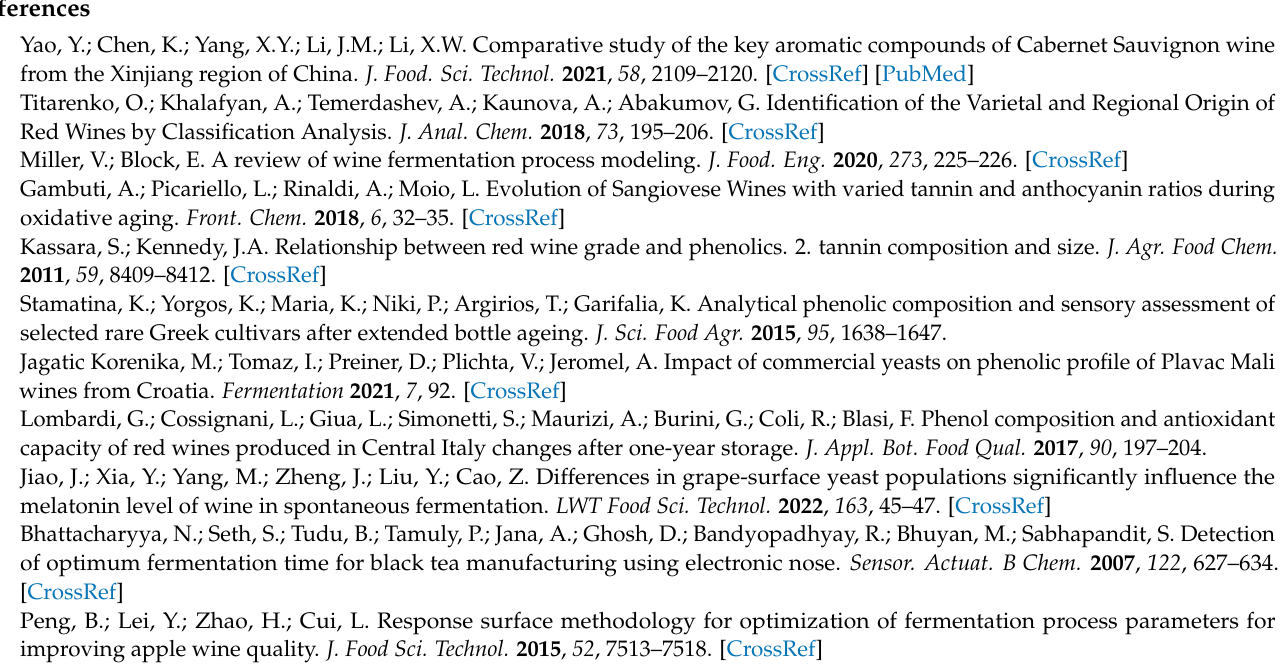
(b); Figure S2: the clustering analysis of twelve phenolic compounds in seven grape cultivars (a) and corresponding wines (b); Figure S3: overlay of the main ion chromatograms of seven varieties of wine; Table S1: antioxidant activity (mmol TE/L) in seven varieties of wine; Table S2: selected volatile compounds found in seven varieties of grapes ( µ g/kg); Table S3: selected volatile compounds found in seven varieties of wines ( µ g/L)